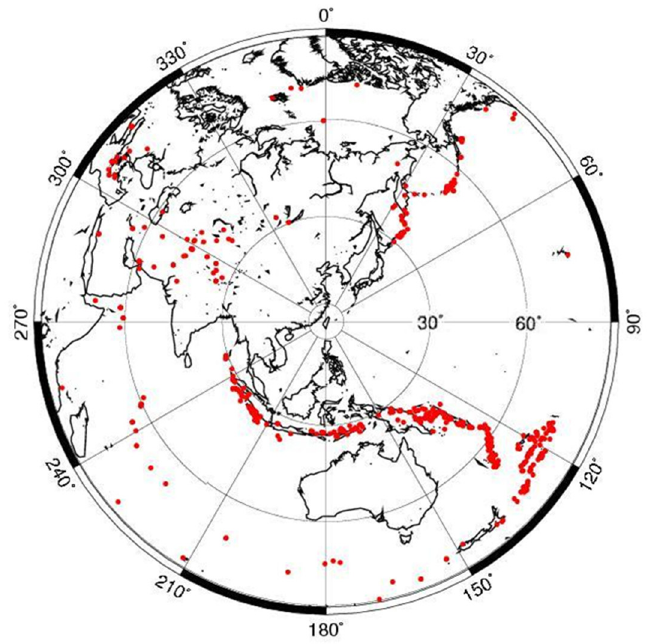
Figure 3. The red dots are the positions of the epicenters of the teleseismic earthquakes used in this study, in which the magnitudes are larger than 5.0 Mw and the epicenter distances are between 30° and 90°.